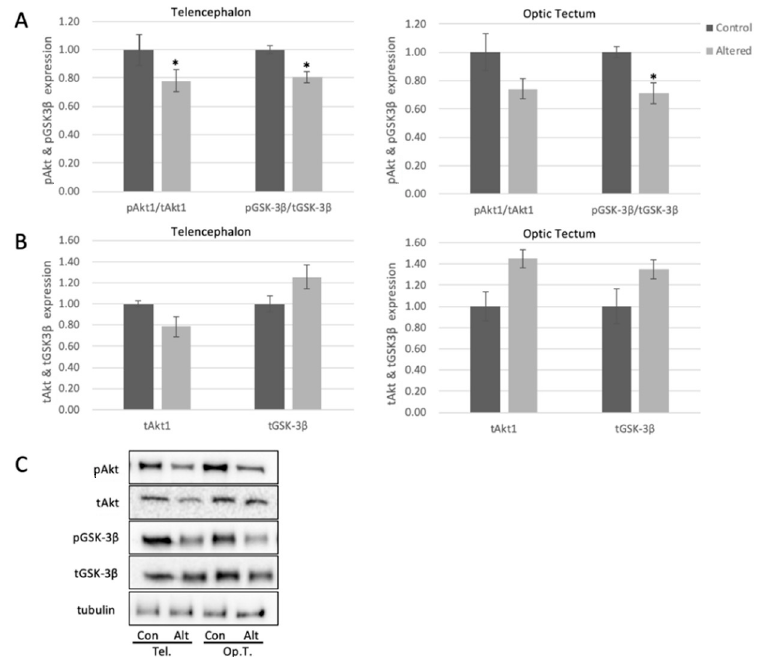
Figure 3. Alterations in light exposure dysregulates Akt and GSK3 β in the telencephalon and optic tectum of adult zebrafish. ( A ) Quantified levels of pSer473Akt and pSer9GSK3 β in telencephalon (Telencephalon pAKT: p = 0.0494, t = 2.180; Telencephalon pGSK: p = 0.0483, t = 2.0754) and optic tectum (Optic Tectum pGSK3 β : p = 0.0335, t = 2.3570) of control and light-altered adult zebrafish. pSer473Akt was normalized to tAkt, and pGSK3 β was normalized to tGSK3B. Control protein expression was set to 1.00. ( B ) Quantified levels of Akt and GSK3 β in telencephalon and optic tectum of control and light-altered adult zebrafish. Akt and GSK3 β were normalized to tubulin. Control protein expression was set to 1.00. Error bars represent SEM. * p < 0.05, n = 8 ( C ) Representative Western blot images; tubulin shown as loading